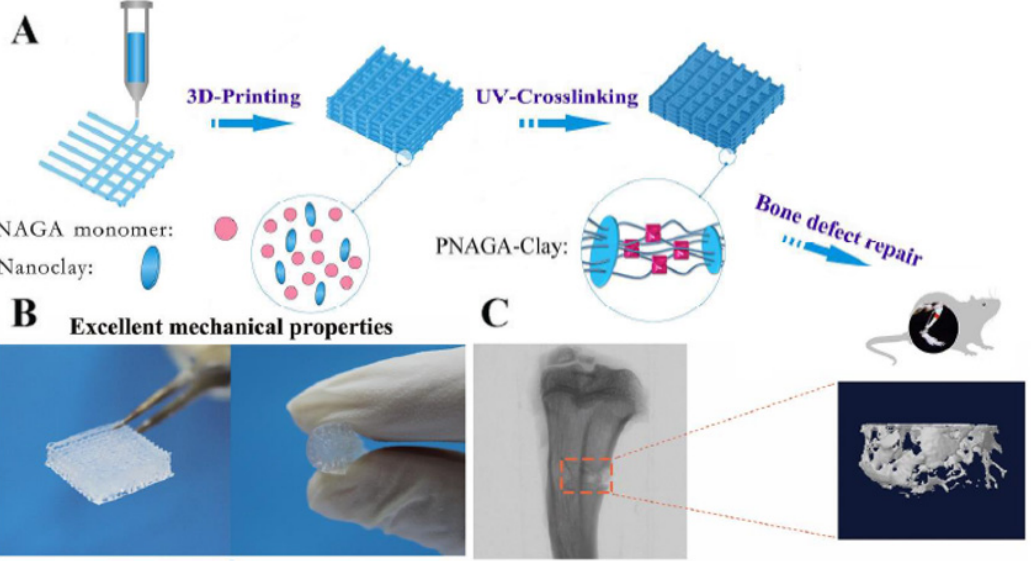
Figure 18 . ( A ) 3D-printed PNAGA–clay scaffold procedure. ( B ) Scaffold’s capacity to resist finger compression. ( C ) Micro-CT characterization of implant and new bone formation and reconstructed 3D model of the new bone. (Adapted with permission from [54]. Copyright 2017, American Chemical Society). Table 2. Clay nanoparticles in hydrogel nanocomposites for bone tissue regeneration.